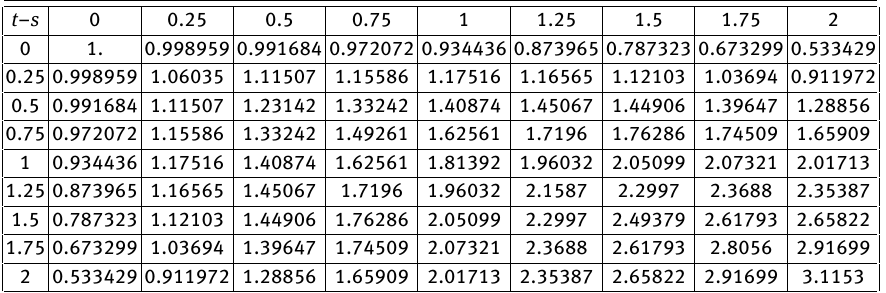
Table 3: Approximation of C ov[ X ( t ), X ( s )] via adapted gPC with p = 3 and p = 4 . Example 4.1, assuming independent random